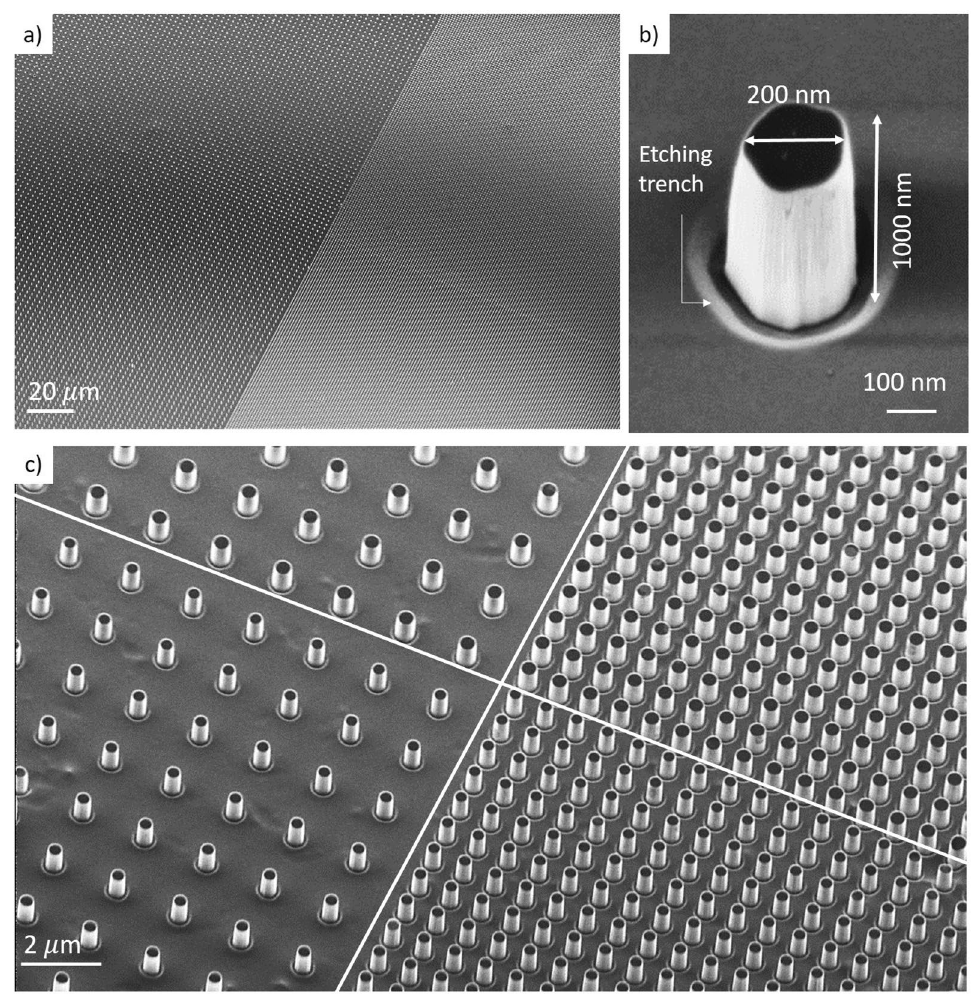
Figure 2. ( a–c ) SEM images of adjacent diamond pillar square arrays. They reveal high homogeneity and smooth and clean diamond surface between the pillars. ( b ) SEM image of an individual diamond pillar, with a diameter of 200 nm and a height of 1 µ m. As a result of the optimized etching process, the top is flat and the sidewalls exhibit high